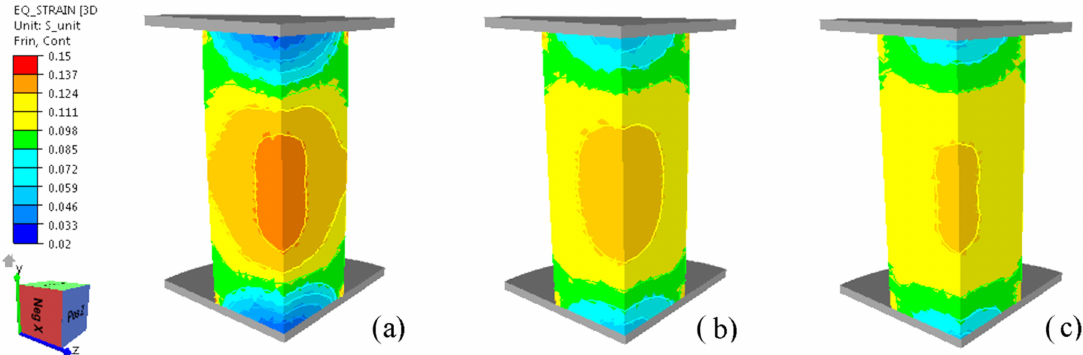
Figure 20. Equivalent strain distribution at 10% deformation for different friction conditions: ( a ) µ = 0.113; ( b ) µ = 0.055; ( c ) µ =